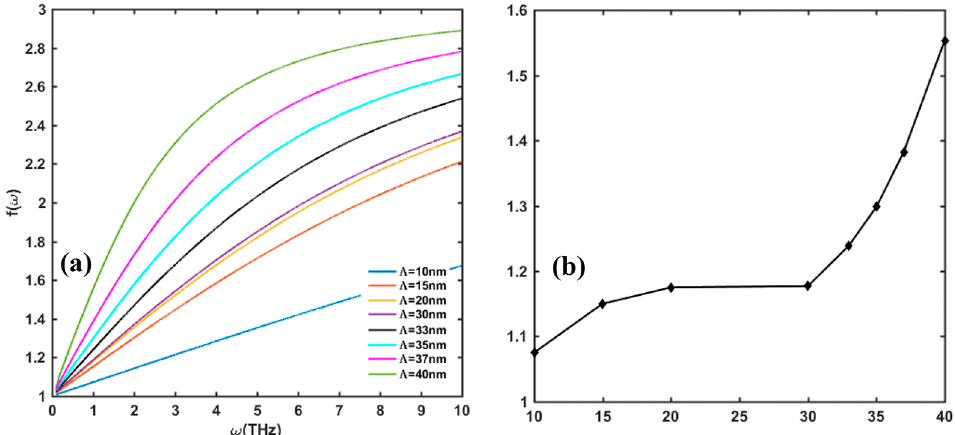
Figure 9. ( a ) Variation in f ( ω ) with lateral correlation length Λ in frequency range of 0.1–10 THz. ( b ) Value of f ( ω ) at 1 THz incident frequency with change in Λ . Other parameters are taken as n s = 10 13 /cm 2 , N dis = 10 10 /cm 2 , and Δ = 1 nm.